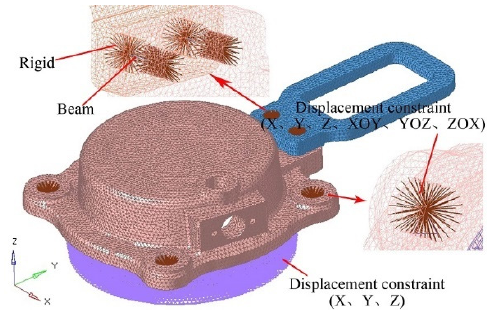
Figure 11. FE model of the wheelset lifting mechanism.